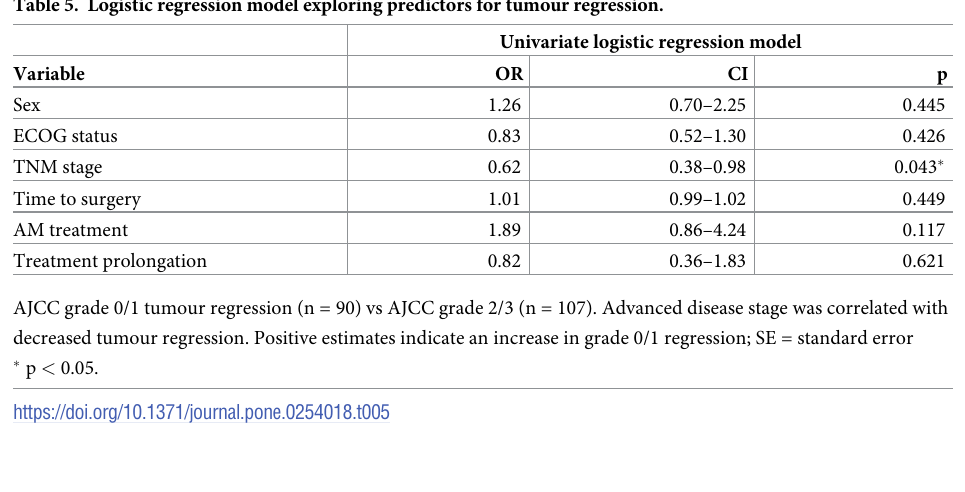
by median time to surgery, AM/PM treatments demarcated by at least 50% of treatments occurring in either the morning or afternoon. Differences were not statistically significant.